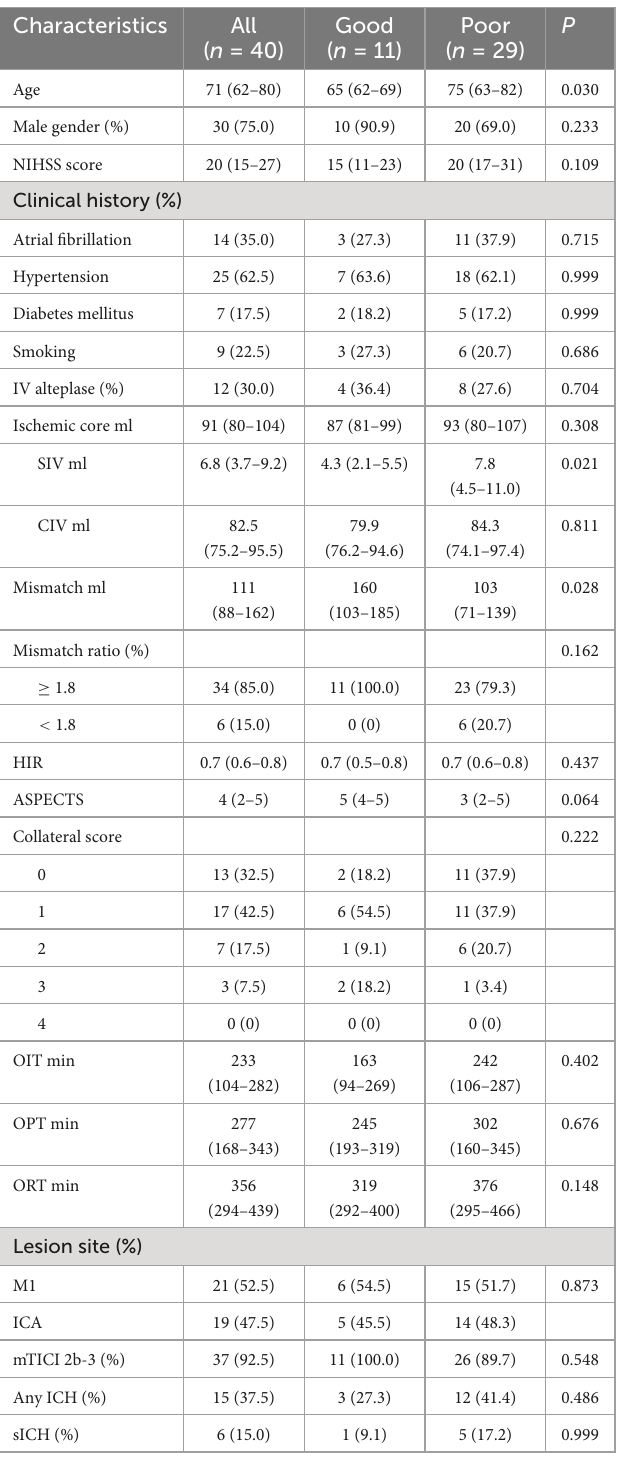
TABLE 1 Baseline, procedural, and outcome parameters. Characteristics